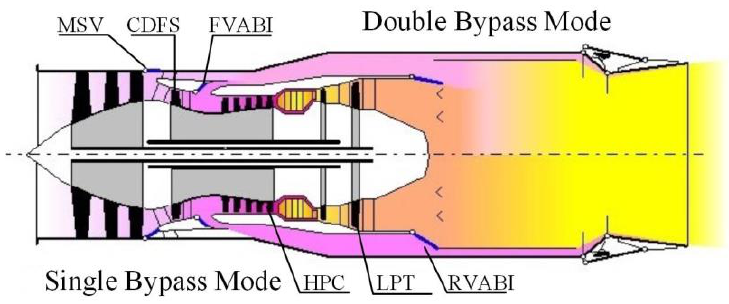
Figure 3. Schematic diagram of the variable cycle engine.